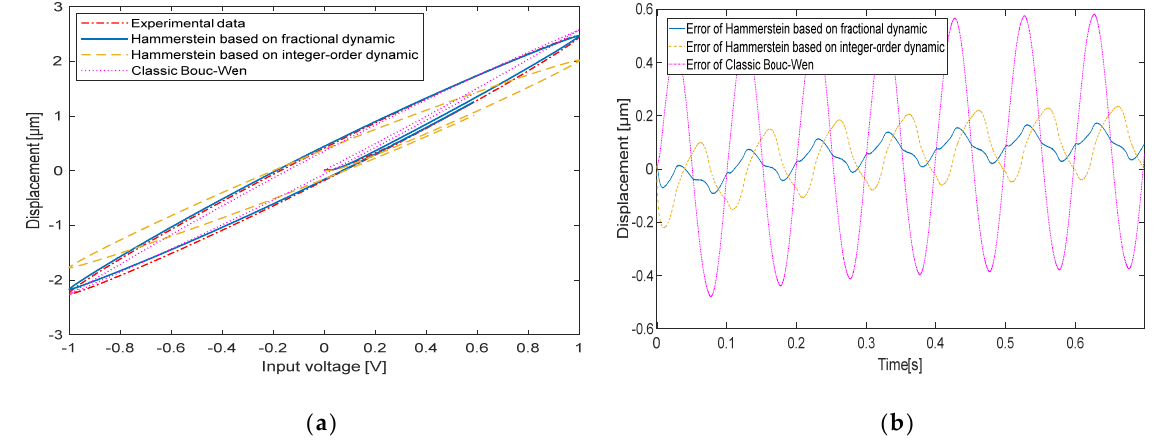
Figure 8. The comparison between experimental data and the Hammerstein model at 10 Hz: ( a ) Hysteresis loop; ( b ) Time curve.